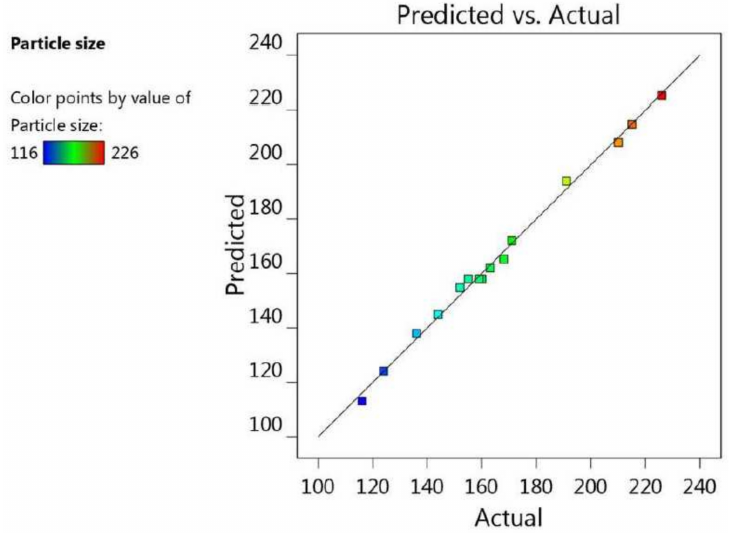
Figure 3. Predicted versus actual plot representing the linear correlation between values for particle size response (R 1 ).